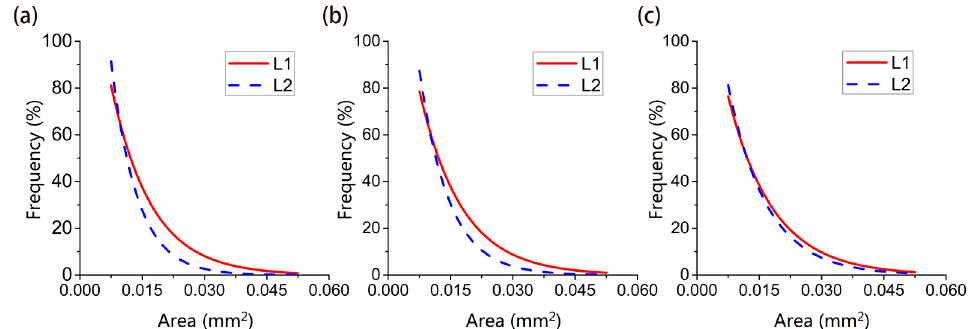
Figure 9. Comparison of fitting curve of probability distribution; ( a ) comparison of distribution curves 30-day, ( b ) comparison of distribution curves 60-day, ( c ) comparison of distribution curves of 90-day.